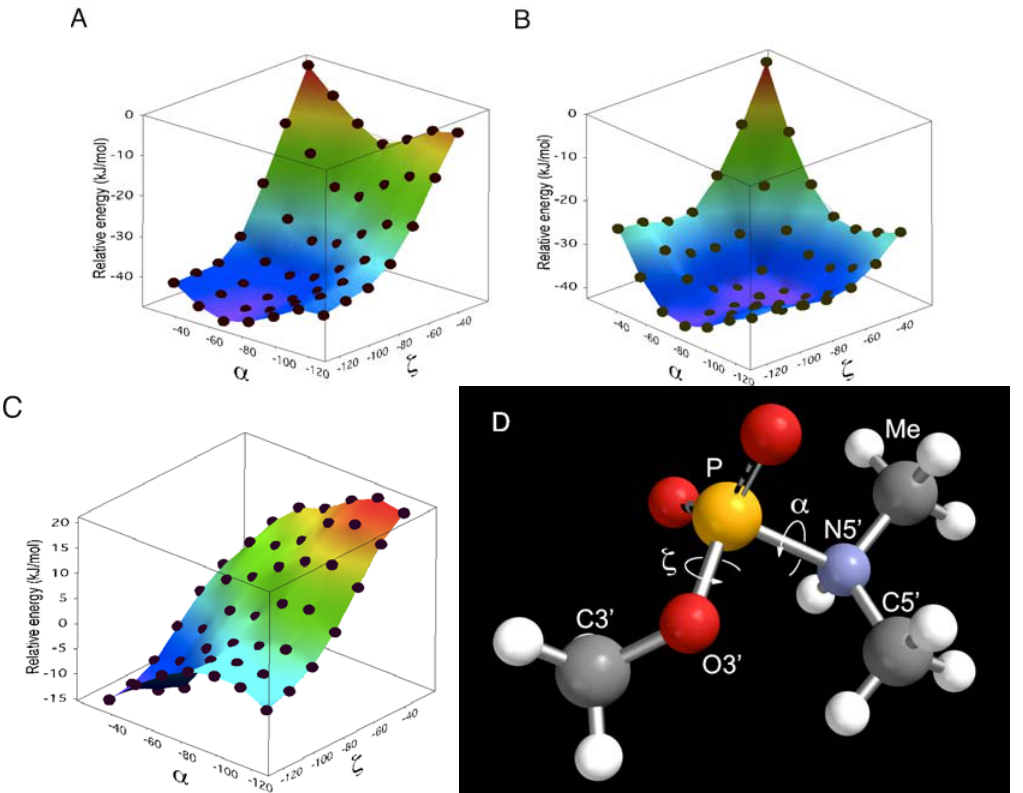
Figure 6. Relative energy of phosphoramidate model compound as function of α and ζ dihedral angles. The relative energy was calculated from the minimized structure at density functional B3LYP/6-311+G** level of theory. The calculation was performed in vacuo with the two dihedral angles corresponding to α and ζ constrained to angles ranging from − 120° to − 30° in increment of 15°. The relative energy profiles of the neutral form ( A ) and anionic form ( B ) are shown. The N-protonated (zwitterionic) form was used as the neutral form. The difference in relative energy between anionic form and neutral form ( C ) was calculated by subtraction of relative energy of anion form ( B ) from that of neutral form ( A ). The most basic conformer studied here is shown ( D ; α and ζ were –30° and –120°, respectively). α : O3’-P-N5’-C5’, ζ :